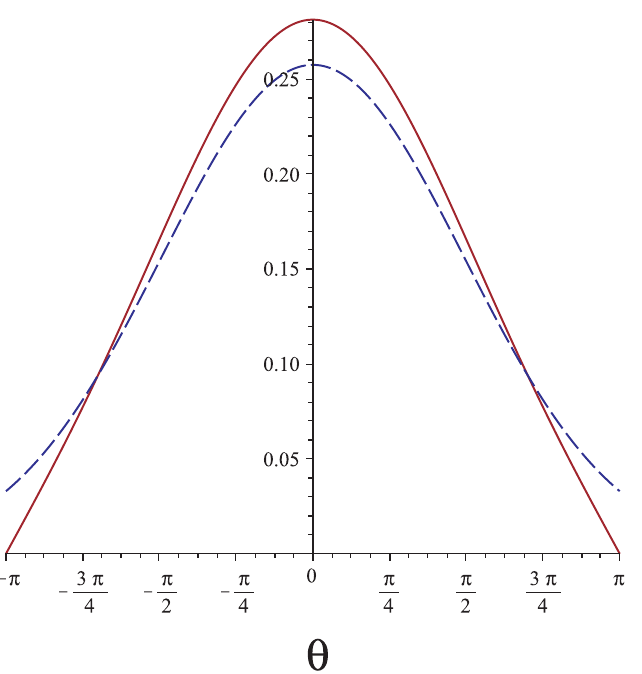
Figure 6. The probability density of the bending angle of a WLC hinge with ratio of contour length to persistent length s / l p = 1.2. The dashed line is the usual Gaussian, whereas the solid line is obtained by imposing absorbing boundary conditions to Equation